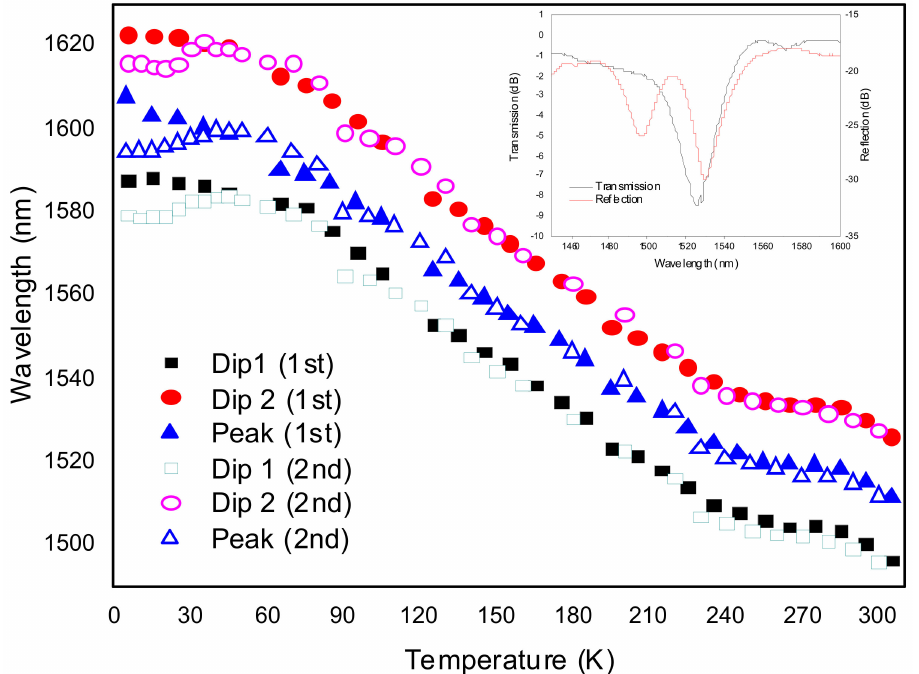
Figure 12. Wavelength of the two Dips and the Peak of the PS-LPFG, inscribed in the B/Ge co-doped fiber, as a function of temperature. Inset: PS-LPFG reflection spectrum. Adapted with permission from ref. [100]. © 2021